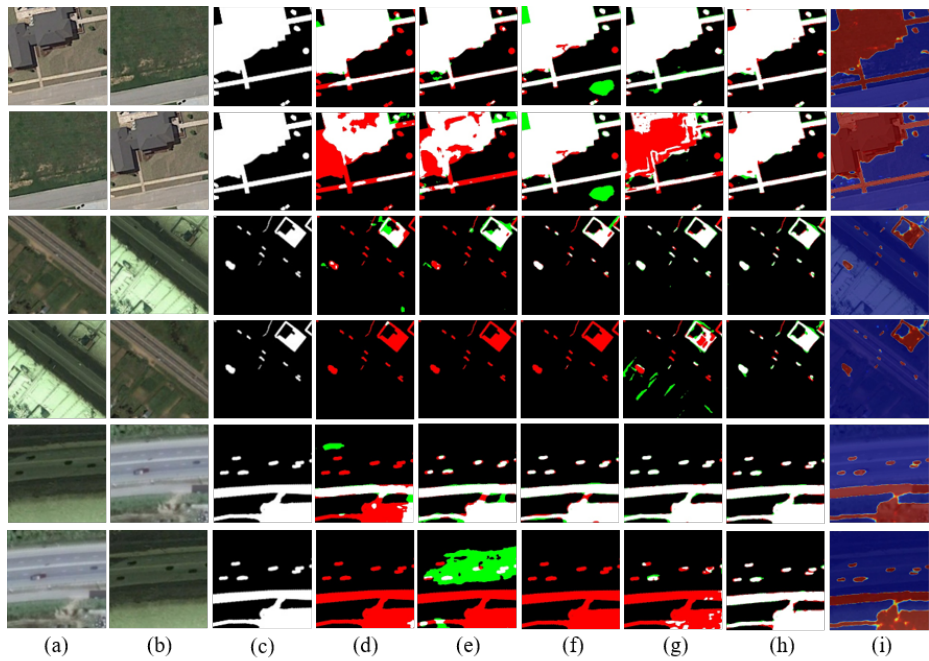
Figure 9. Qualitative comparison including the detected changes from image t1 to image t2 and changes from image t2 to image t1 on the CDD dataset. The odd and even rows represent the detection results from image t1 to image t2 and results from image t2 to t1, respectively. TP is shown in white, TN is shown in black, FP is shown in green, and FN is shown in red: ( a ) prechange, ( b ) postchange, ( c ) ground truth, ( d ) FC-siam-diff, ( e ) UNet++MSOF, ( f ) IFN, ( g ) DCFF-Net, ( h ) our proposed model, and ( i ) attention